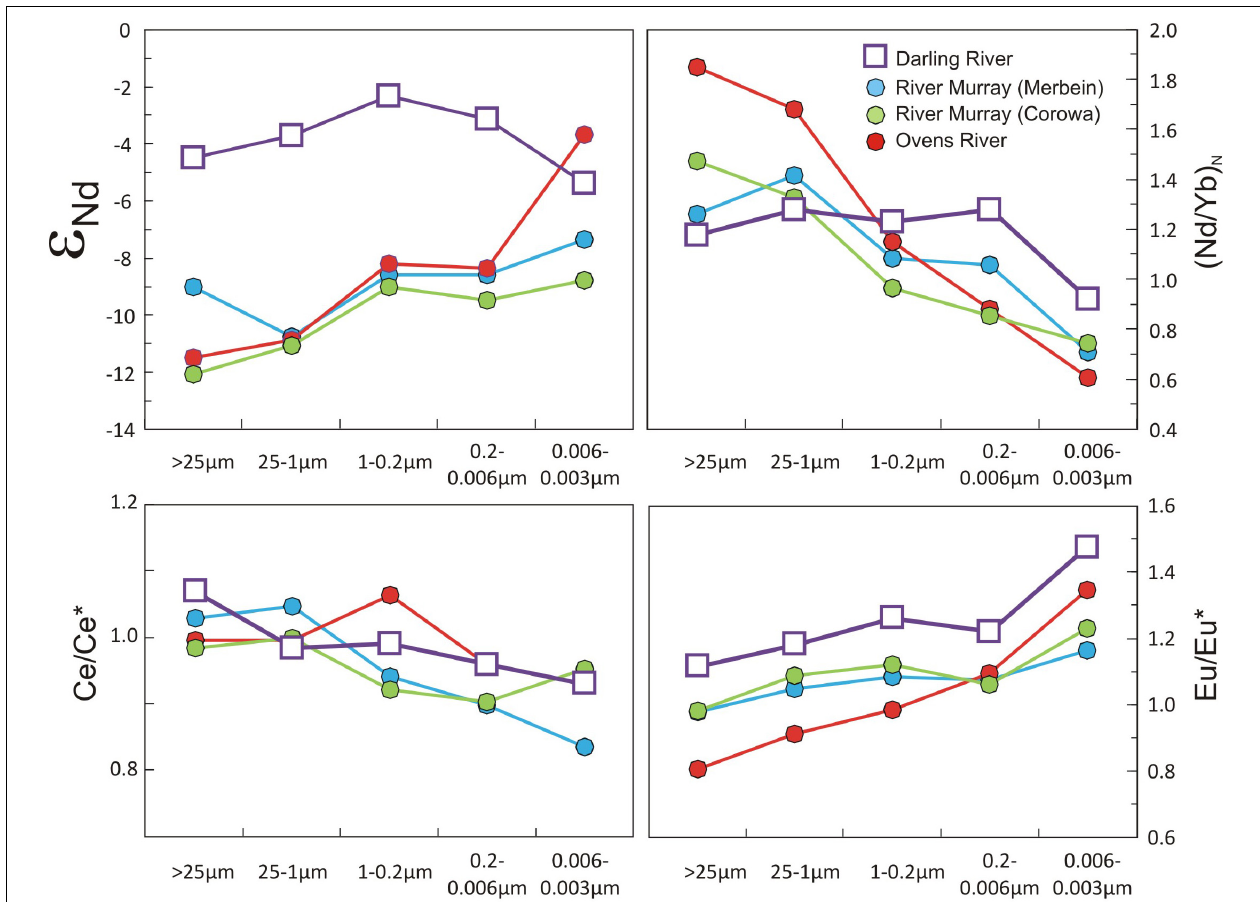
FIGURE 3 | Size-dependent variability of Nd isotope, WRAS-normalized Nd/Yb ratios (Nd/Yb) N , and cerium- (Ce/Ce*) and europium- (Eu/Eu*) anomalies in river suspended material from the Murray-Darling Basin. Grain-size fractions from River Murray and Ovens River suspended particulates illustrate the effect of grain-size on Nd isotopic compositions and REE